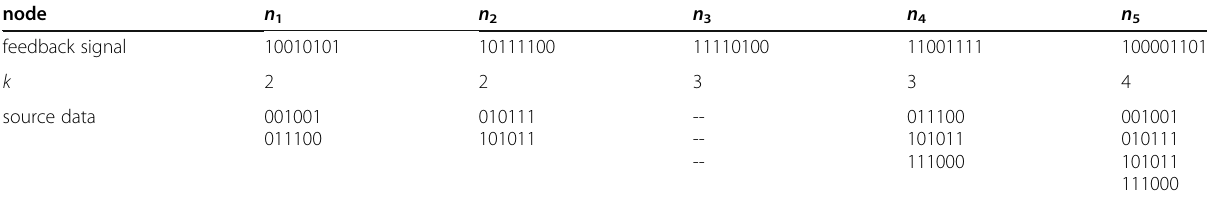
Table 3 Data verification of n 1 - n 5